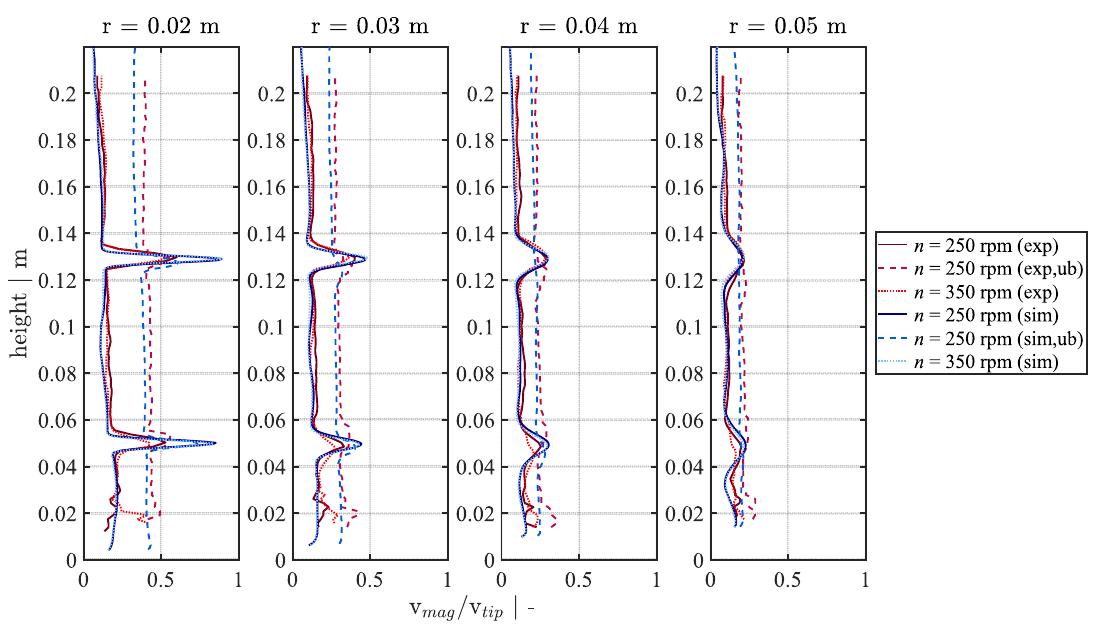
Figure 6. Comparison of the dimensionless axial time- and azimuthal-averaged velocity profiles.